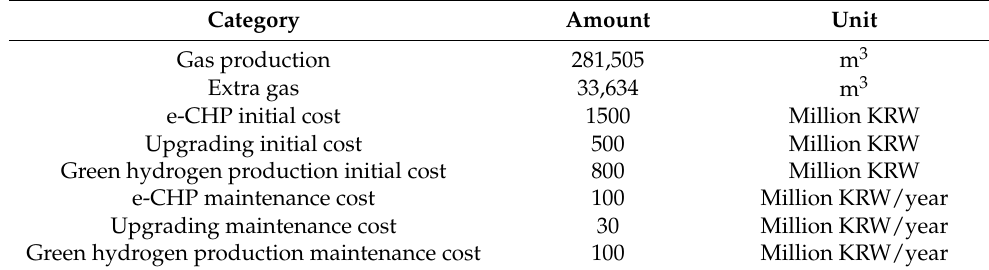
Table 5. Facility A fixed definition.